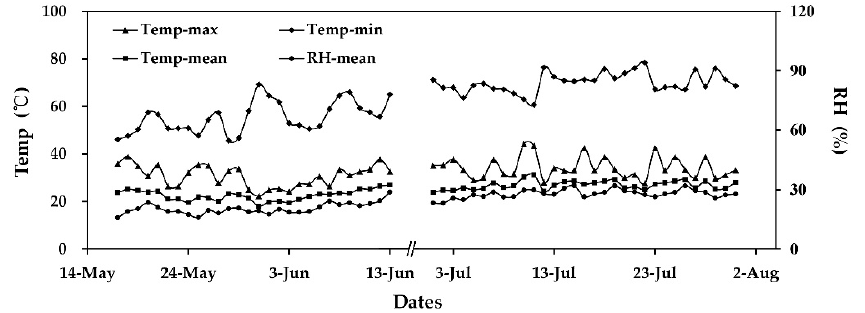
Figure 2. The daily air temperature (Temp) and relative humidity (RH) during the measurements. The Temp and RH during the measurements on scion-rootstock combinations from 17 May 2021 to 13 June 2021, and on M.9 clones from 1 July 2021 to 30 July 2021 were recorded, respectively. Four types of points represent the maximum air temperature (Temp-max), the minimum air temperature (Temp-min), the mean air temperature (Temp-mean), and the mean relative humidity (RH-mean) in a day. Jun, Jul, and Aug are abbreviations for June, July, and August, respectively.